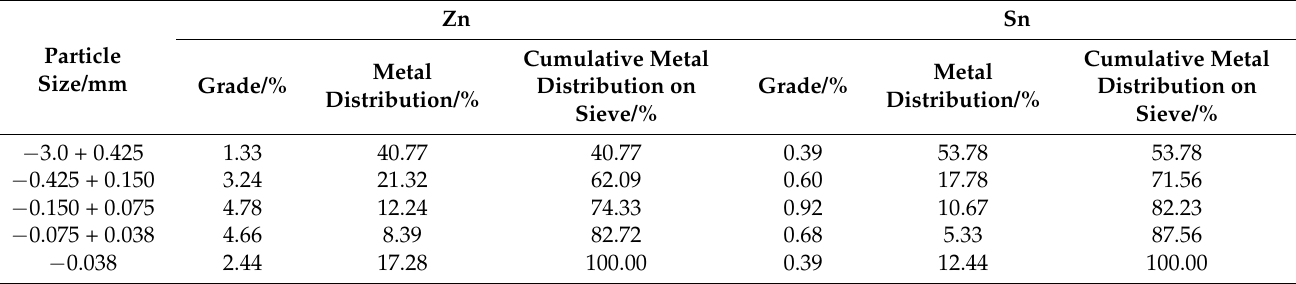
Table 2. Grade and metal distribution of Zn and Sn in the